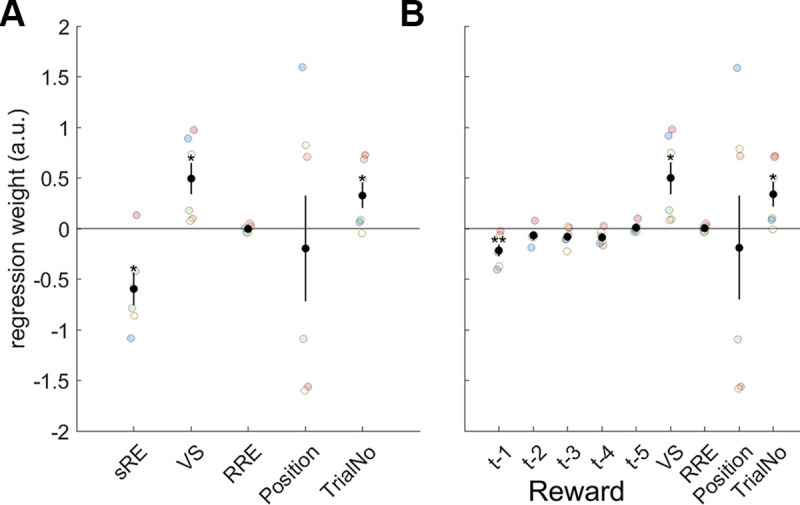
Behavioral effect of surprising events.GLMEs predicting errors or outliers as a function of 3 types of surprising event: sRE, VS, and RRE. The 2 GLMEs only differ in that, in A, sRE is indexed by a single regressor while in B, sRE is not a single regressor but instead its component parts are made explicit in terms of the reward outcome experienced on the last 5 trials (t-1 to t-5). Dots represent the beta weight associated with each regressor determined by a GLME applied to each monkey separately. Black dots indicate group mean effects according to the full GLMEs, and vertical bars indicate the SEMs. The Position effect indicates that animals were more likely to make errors or outlier responses depending on the side of the screen they had to respond to but that different animals had different side biases. Errors and outliers became more likely as each session progressed and TrialNo increased. Data and code to reproduce the figure can be found at https://doi.org/10.5281/zenodo.3993116. a.u., arbitrary units; GLME, generalized linear mixed-effect model; RRE, rare reward event; SEM, standard error of the mean; sRE, scalar reward expectation; TrialNo, trial number; VS, visuospatial surprise.